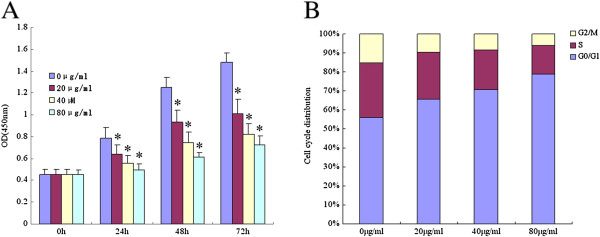
Effect of Astragalus saponins on proliferation and cell cycle of BGC-823 cells. A. Astragalus saponins inhibited proliferation of BGC-823 cells. Cells were treated with, 20 μg/ml, 40 μg/ml, and 80 μg/ml Astragalus saponins, 0 μg/ml as a control, and cell proliferation was assessed using the CCK8 assay. Data are presented as the mean of triplicate experiments. The growth inhibitory effect of the Astragalus saponins was time and dose dependent, with the maximum inhibition detected 72 h after treatment. *Significant difference (p < 0.05). B. Astragalus saponins impaired cell cycle progression in BGC-823 cells. Cell cycle distribution was analyzed by flow cytometry. Data are presented as the mean of triplicate experiments. Administration of Astragalus saponins significantly increased the percentage of cells in the G0/G1 phase, and significantly decreased the S and G2/M phase fractions.